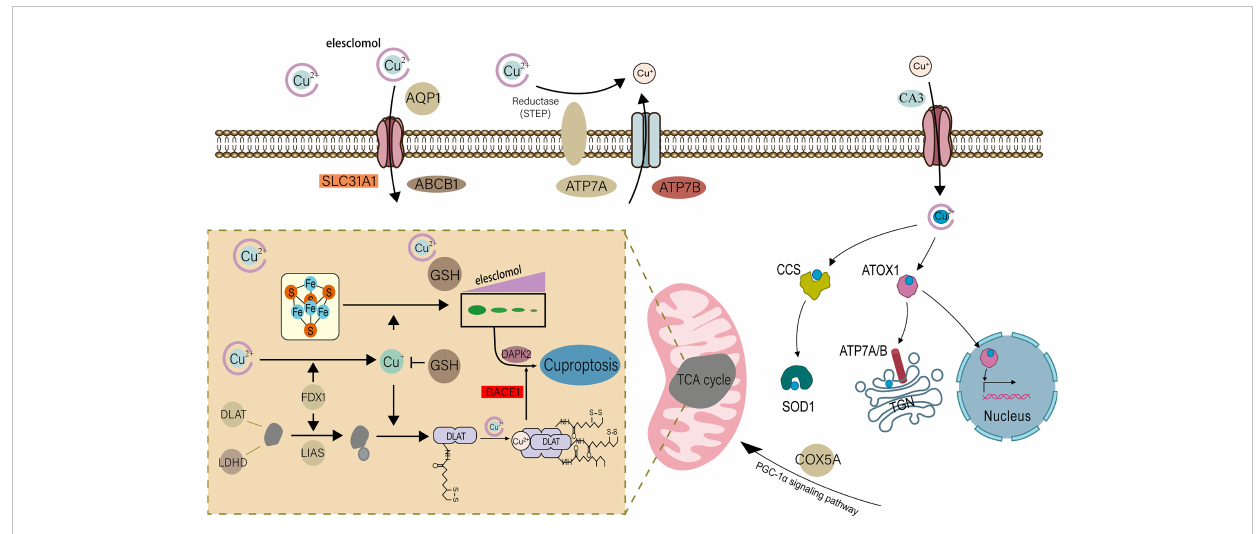
FIGURE 1 Schematic diagram of the mechanism of cuproptosis occurrence in